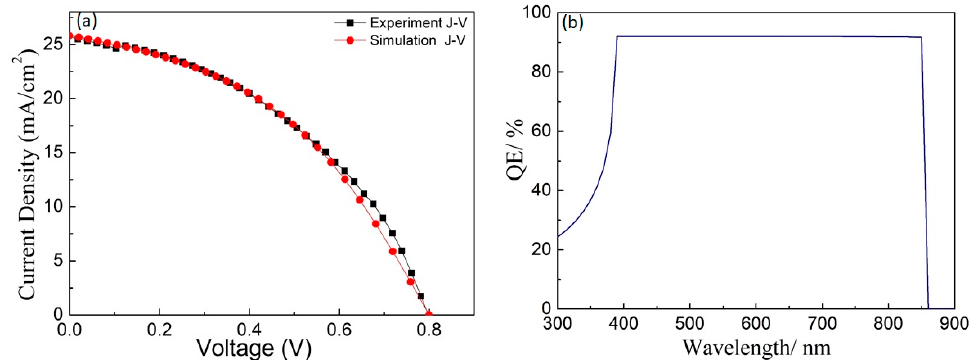
Figure 2. ( a ) The experimental and theoretical J-V curves of the PSC, ( b ) the QE result from the SCAPS. Table 4. Comparison of performance parameters of the experiment and simulation results. Parameter Experiment